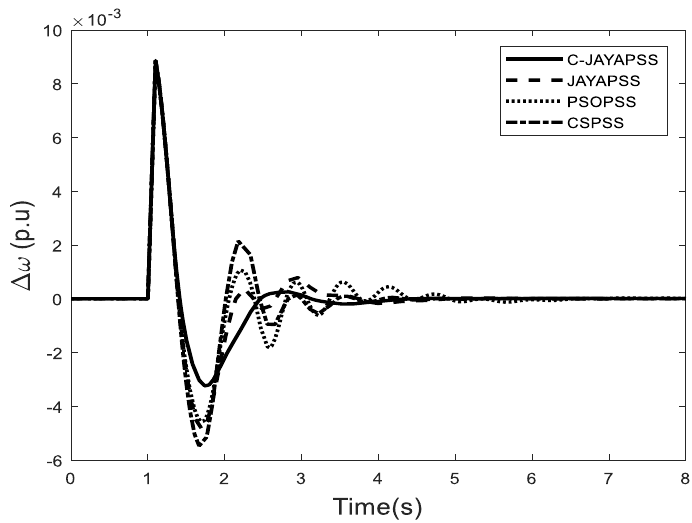
Figure 8. Rotor speed response for a six-cycle fault disturbance with case 1.